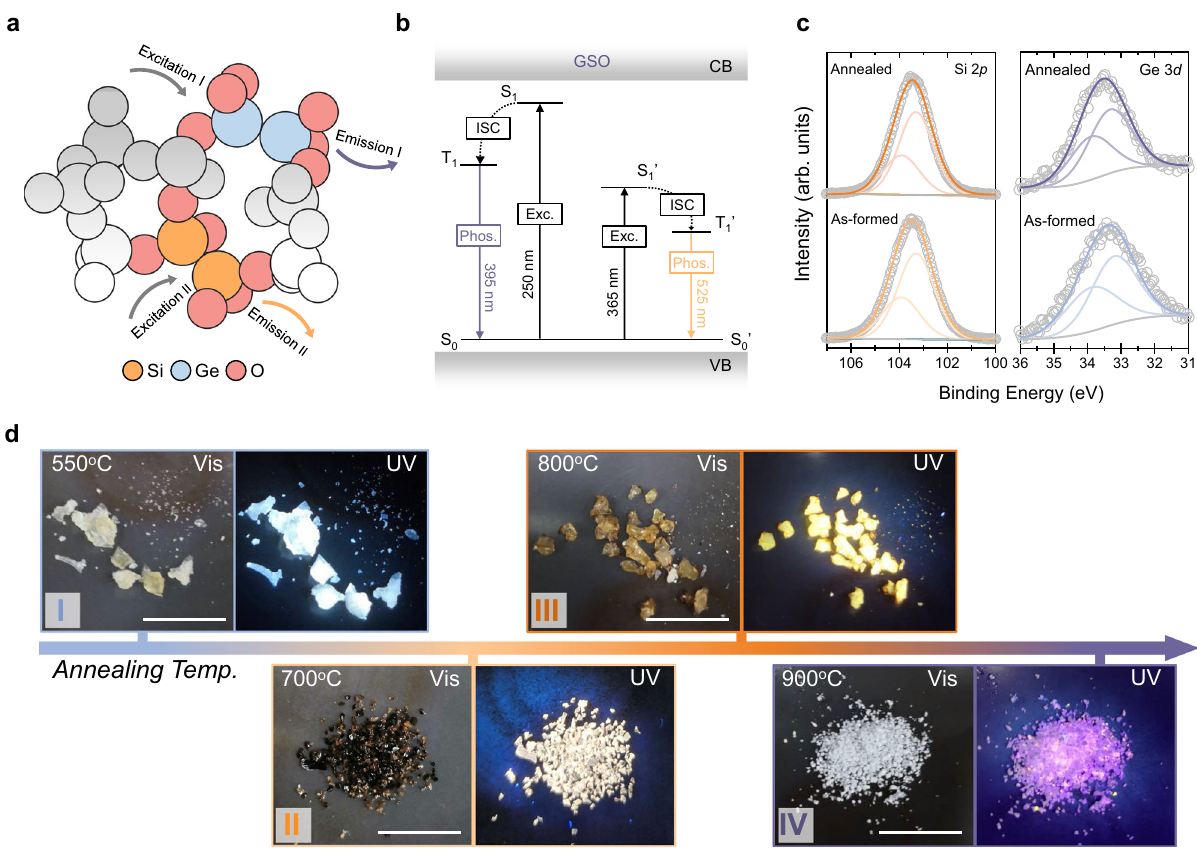
Fig. 1 | Design and synthesis of GSO phosphors. a Rational design of multi- component GSO for colour-tuned phosphorescence. The faded molecules refer to the amorphous SiO 2 scaffold.Byusing different excitation wavelengths (excitation IorexcitationII),onemayselectivelyexciteGe-andSi-basedLCs,demonstratedby different emission wavelengths (emission I or emission II). b Diagram of the pro- posed energy levels of Ge oxygen-de fi cient centre (GeODC(II)) and Si LCs which coexist in GSO solids. VB valence band, CB conduction band, Exc. excitation, ISC